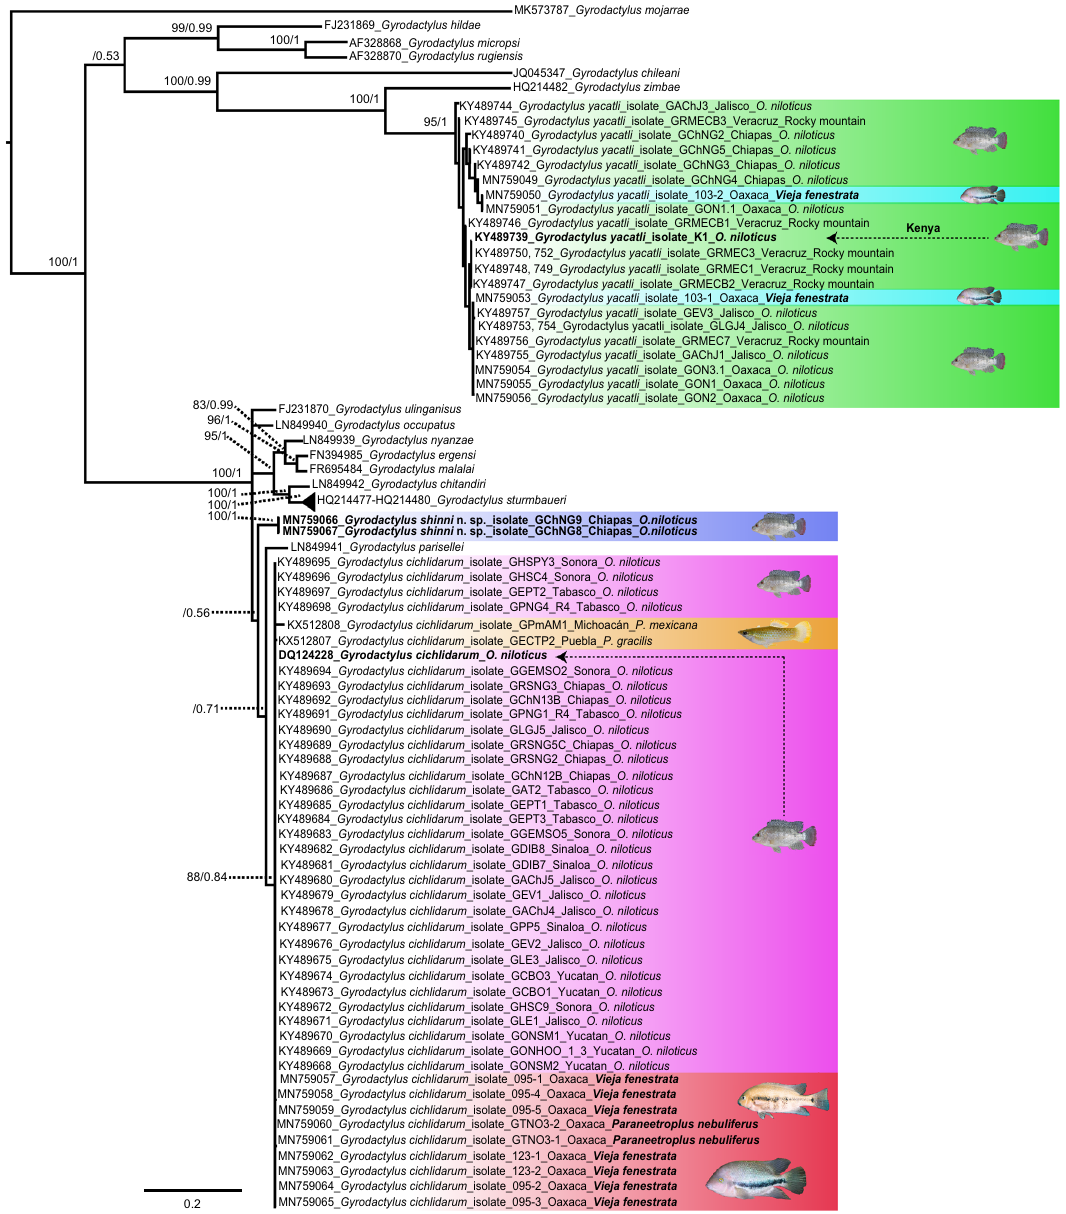
Figure 5. Phylogenetic hypothetical relationships for Gyrodactylus spp. collected from “tilapia” Oreochromis niloticus and from different native cichlids in Mexico. Phylogenetic trees inferred through Maximum Likelihood (ML) and Bayesian Inference (BI). Numbers near internal nodes show bootstrap and the posterior probability of clade frequencies. Scale bars indicate the number of substitutions per